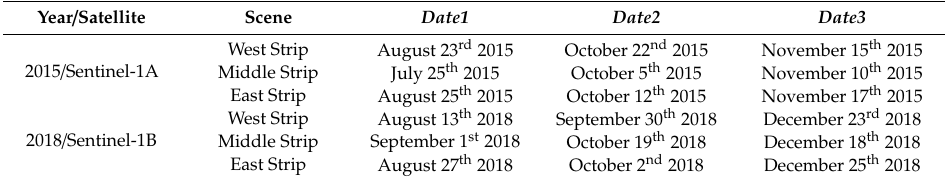
Table 1. Acquisition dates of Sentinel-1 images used in regional forest mapping.